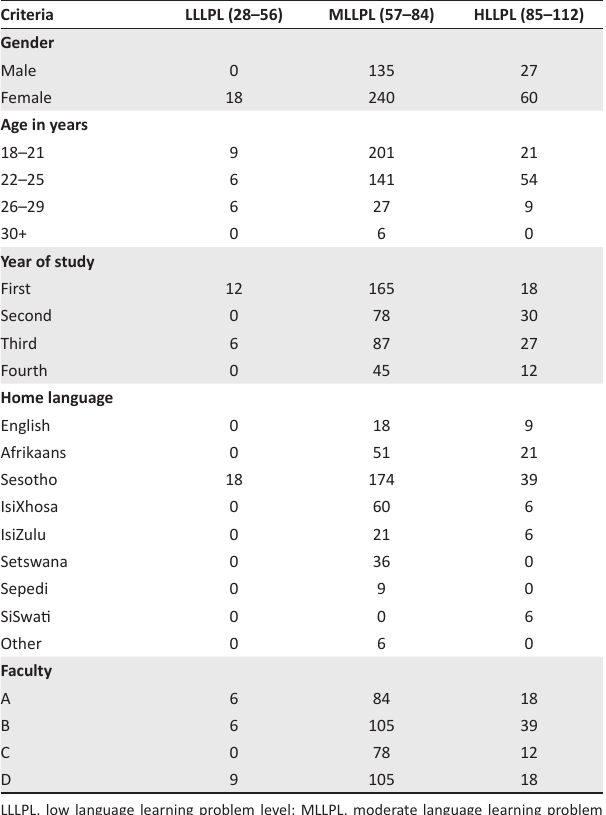
TABLE 1: Biographical variables and students’ language learning